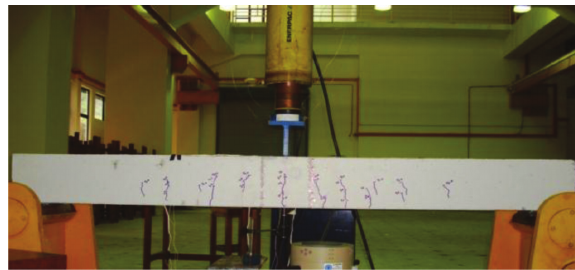
Fig. 2. Beam under static test